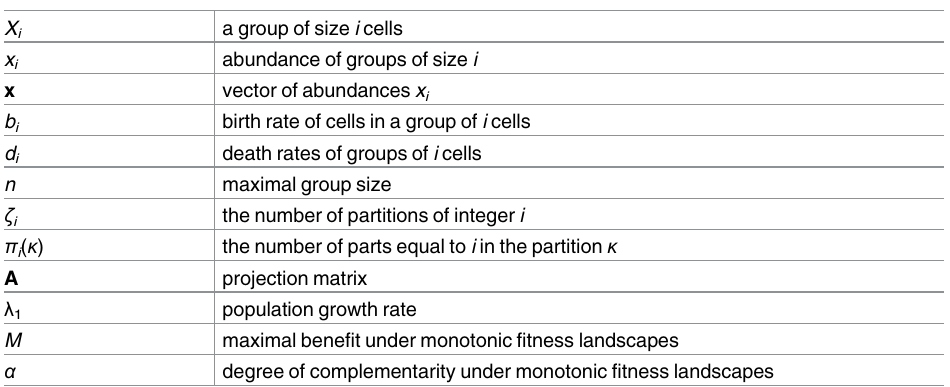
Table 1. List of